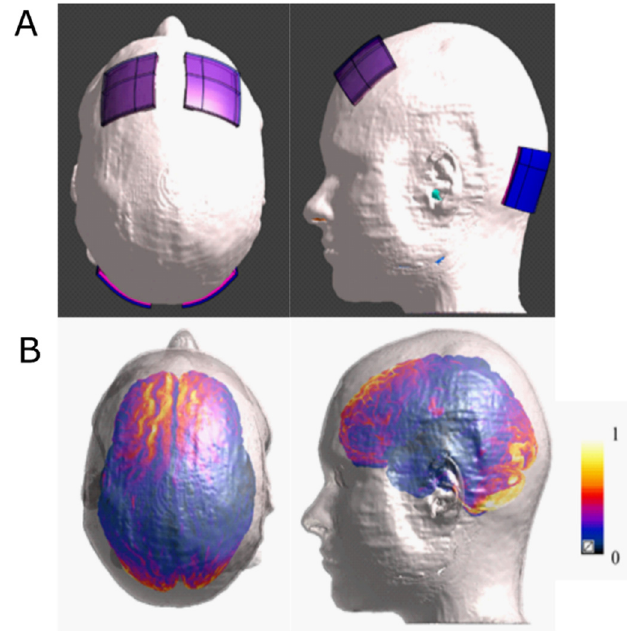
Figure 1. Computational model of electrical field distribution: ( A ) top and lateral views of the electrode positioning on the MIDA model; ( B ) top and lateral views of the normalised electrical field distributions below the stimulating electrode on the cortex and cerebellum. The distributions are normalised with respect to the maximum of the electric field amplitude.